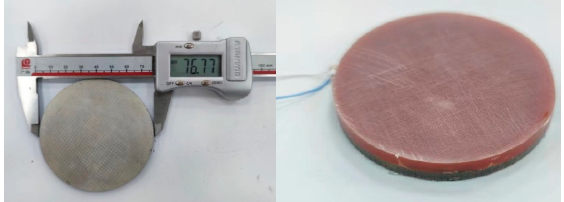
Figure 11. Circular Transmitting Array.